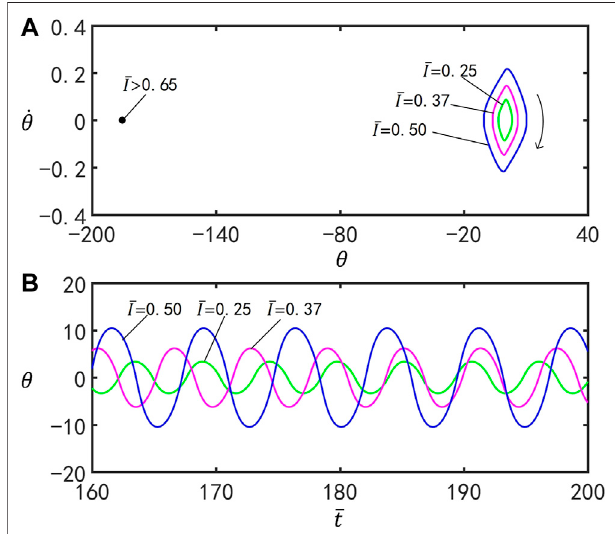
FIGURE 6 | Effects of the light intensity (cid:2) I on self-stabilized oscillation of the inverted pendulum for C 0 (cid:2) 0 . 4, (cid:2) g (cid:2) 9 . 8, (cid:2) ζ (cid:2) 14 . 7, θ 0 (cid:2) 0 ° , θ 1 (cid:2) 70 ° , and _ θ (cid:2) 0. (A) Limit cycle for (cid:2) I (cid:2) 0 . 25, (cid:2) I (cid:2) 0 . 37, and (cid:2) I (cid:2) 0 . 50. (B) Time series for 0 (cid:2) I (cid:2) 0 . 25, (cid:2) I (cid:2) 0 . 37, and (cid:2) I (cid:2) 0 . 50. The amplitude and period of the self- stabilized oscillation increase with the enhancement of (cid:2) I .